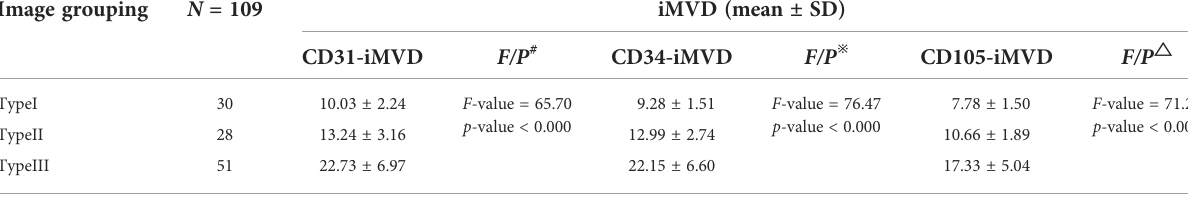
TABLE 3 Correlation between GGN vascular imaging grouping and CD31-, CD34-, and CD105-labeled iMVD. Image